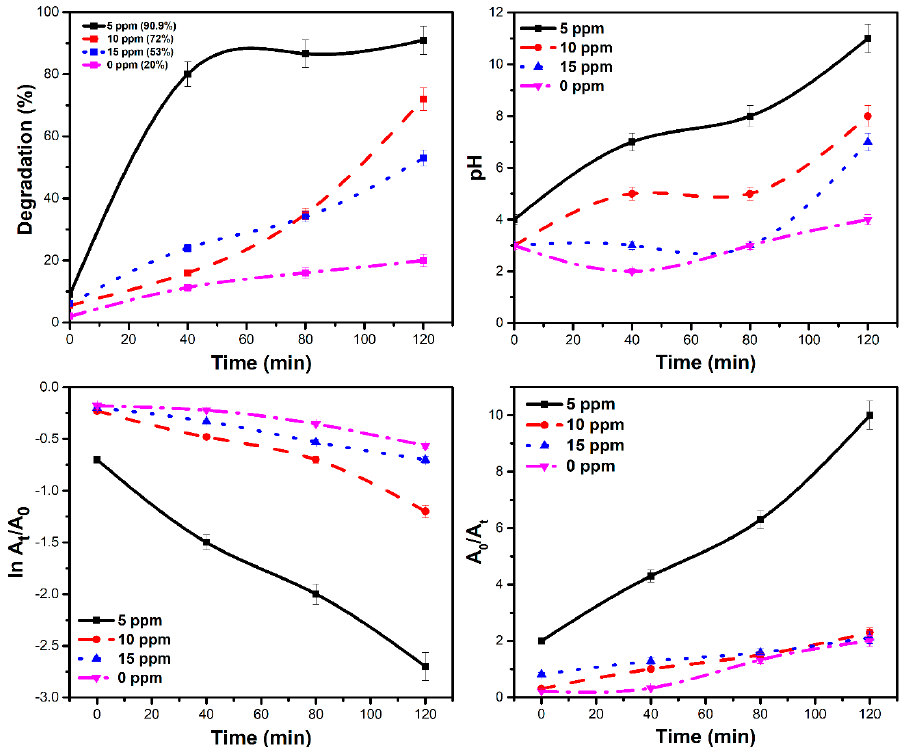
Figure 7. Photolysis and catalytic dye degradation efficiency profiles for different pH values, pseudo-1st-order and 2nd-order models. 1st-order and 2nd-order